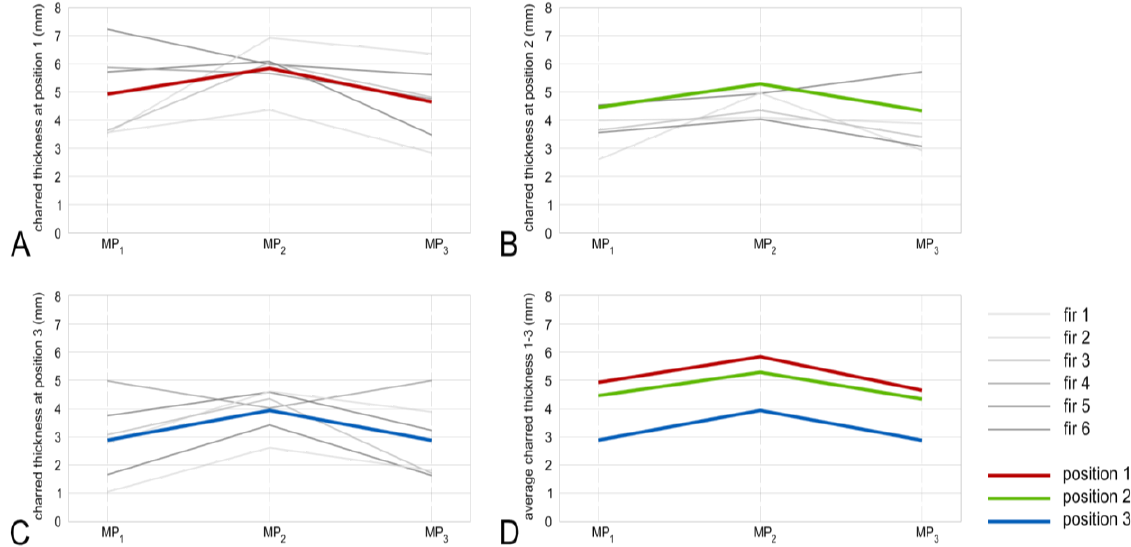
Figure 7. Fir charred layer thickness in cutline 1—bottom ( A ), cut line 2—middle ( B ), cut line 3—top ( C ), and all average thicknesses ( D ).